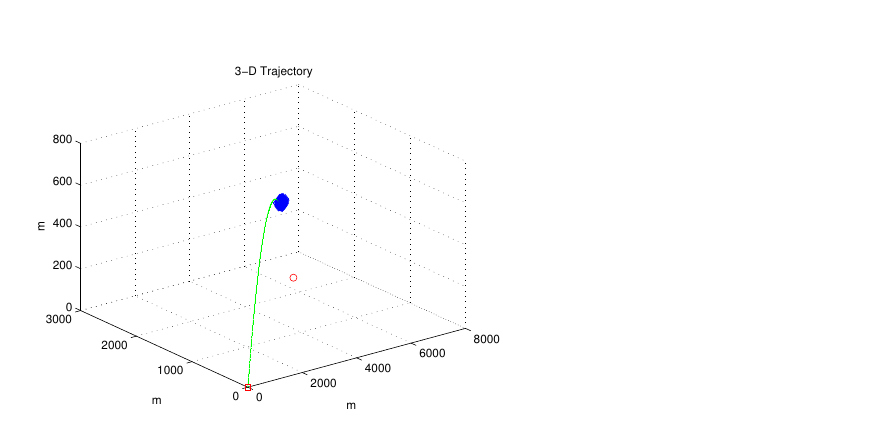
Figure 3. Simulation result using var ψ = 0.1 degree, var θ = 0.1 degree, and var V = 0.1 m/s.